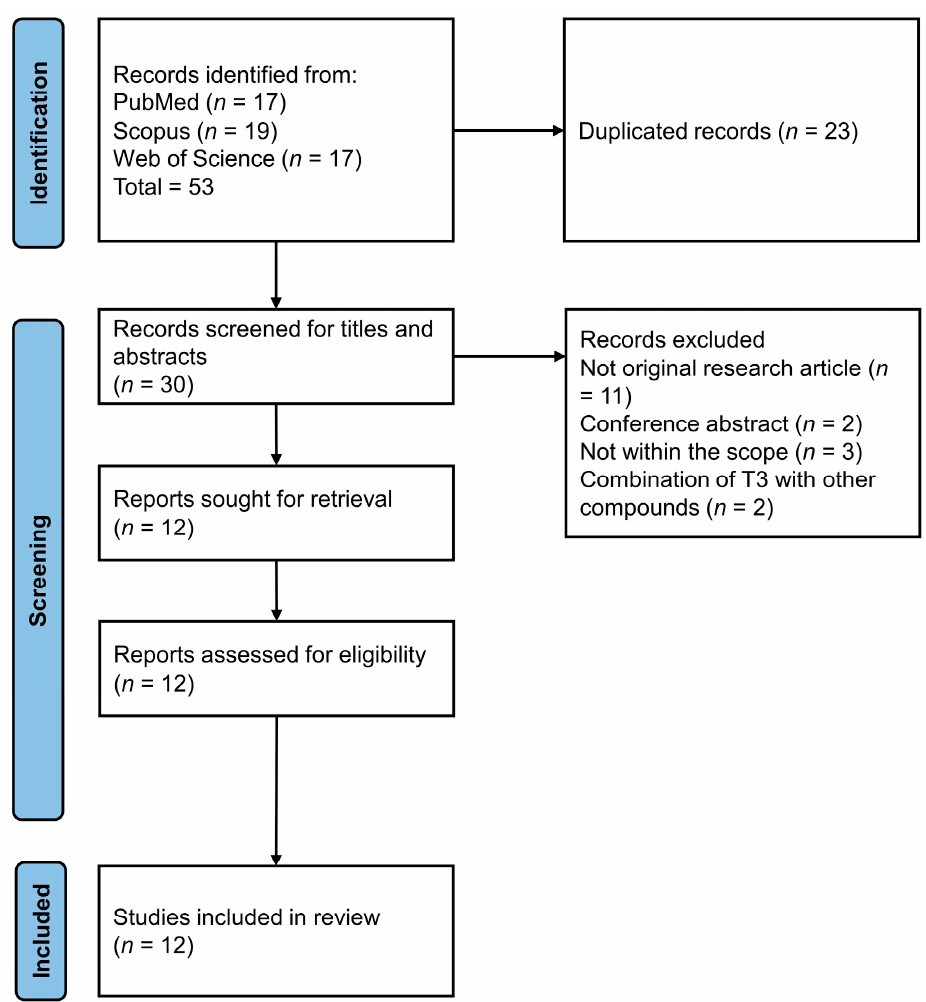
Figure 1. Flow chart of the article selection process.